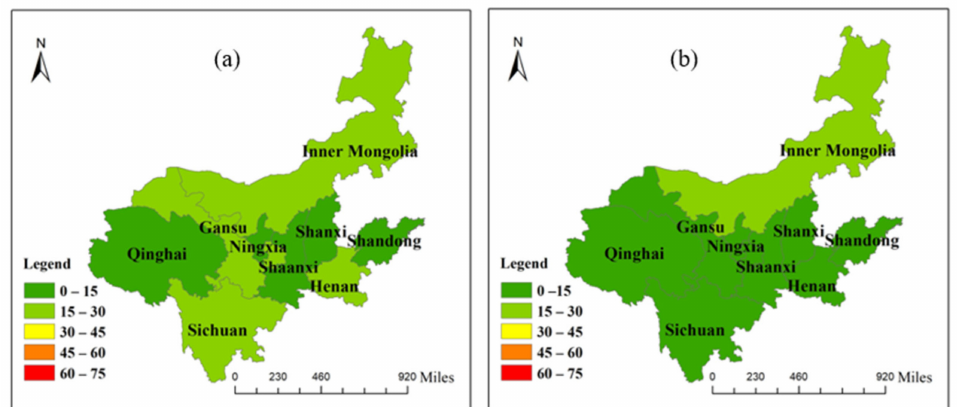
Figure 8. Virtual water outflow of each province in the Yellow River Basin: ( a ) outflow into provinces outside the Yellow River Basin; ( b ) outflow into the Yellow River Basin.